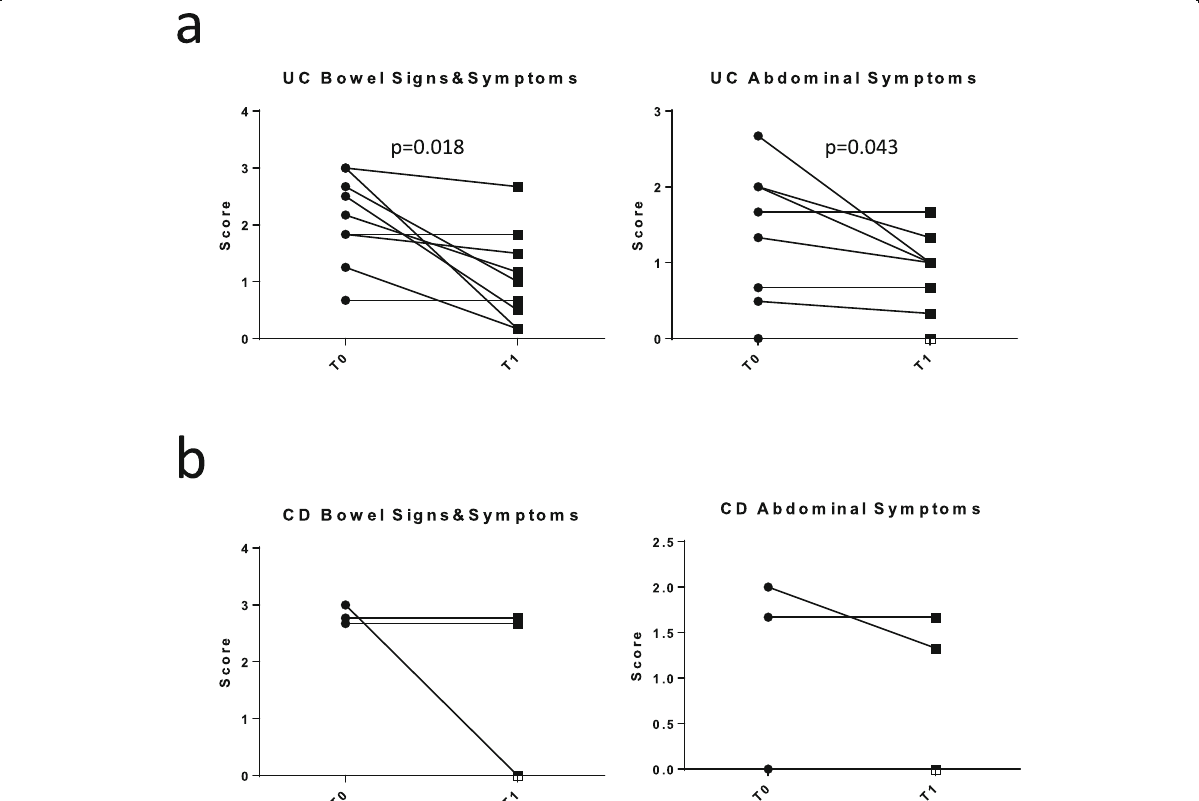
Fig. 3 UC- ( a ) and CD- ( b ) bowel signs and symptoms and abdominal signs evaluated before (T0) and after (T1) therapy escalation. Statistical significance (p value) of differences between the two time points is indicated in the plots. (ns) not